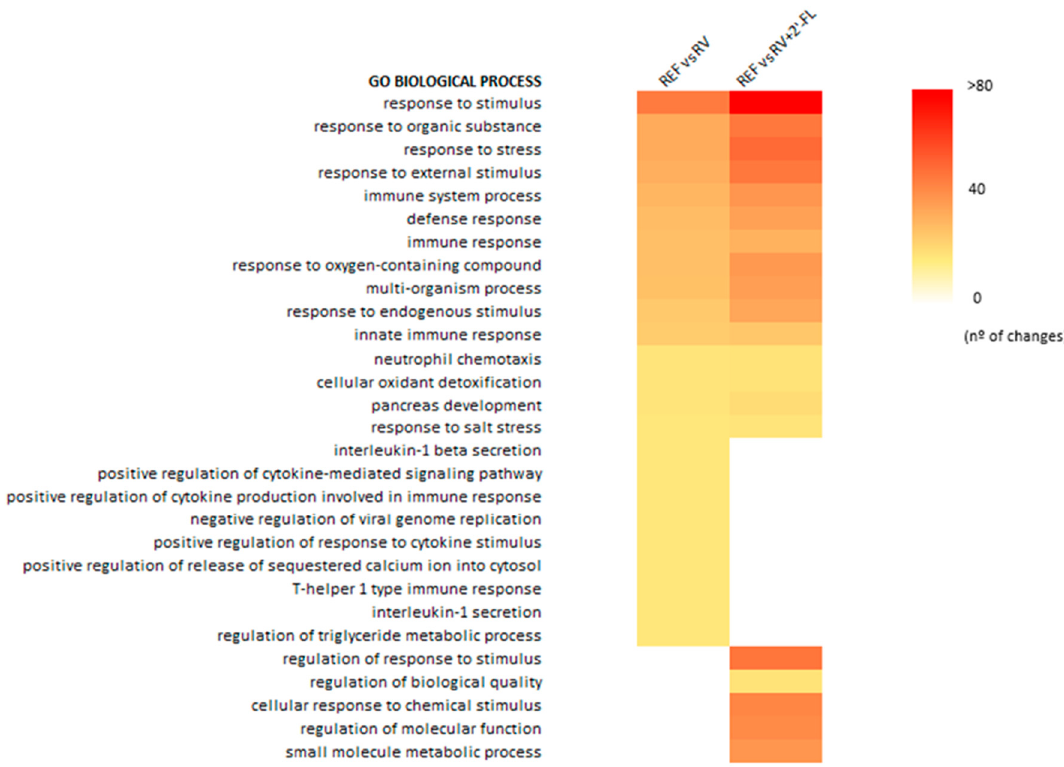
Figure 2. List of the gene ontology (GO) pathways in which higher numbers of statistically affected genes are counted in the array due to the RV infection with respect to the REF group ( n = 4/group).